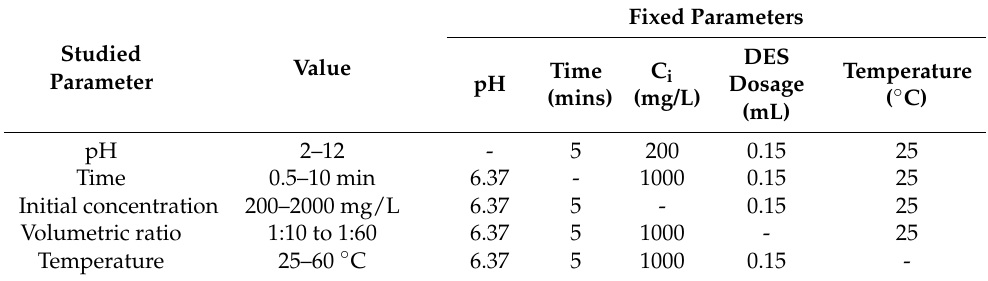
Table 2. Summary of the optimization process for the extraction of alizarin dye by